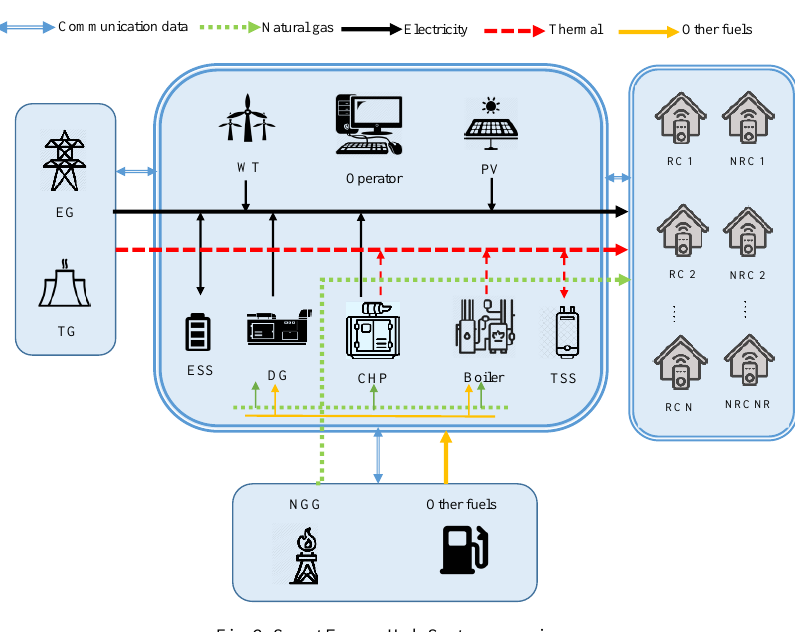
Fig. 2. Smart Energy Hub System